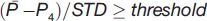
Percentage of companies with Q4 earnings satisfying (P¯−P4)/STD≥threshold
.